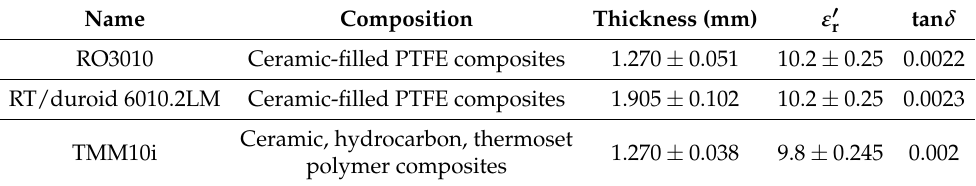
Table 1. Properties of the investigated high-permittivity substrates. Relative dielectric constant and loss tangent values were provided by Rogers Corporation at 10